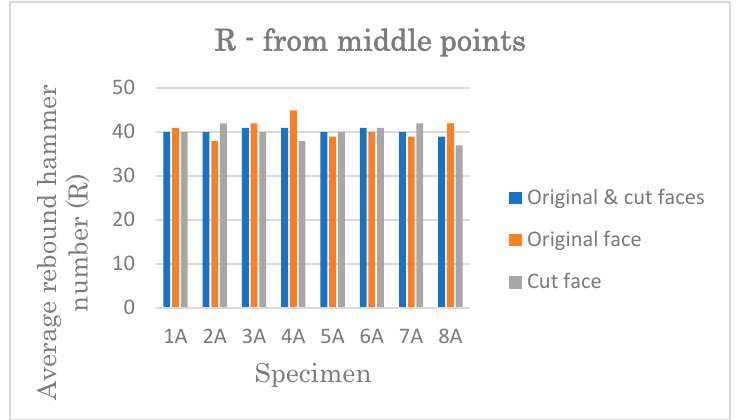
Figure 7 . Average rebound value (R) from middle points. Figure 7. Average rebound value (R) from middle points. In general, the rebound value obtained from middle point is high except for specimen Table 6. Estimated compressive strength from rebound hammer 8A in the case of (b). The correlation between rebound value, which is obtained from mid- dle point regardless of face types and case (b), and the compressive strength is established based on the characteristic curve and empirical equation outlined in Section 2.2 (Table 6). Table 6 . Estimated compressive strength from rebound hammer test.